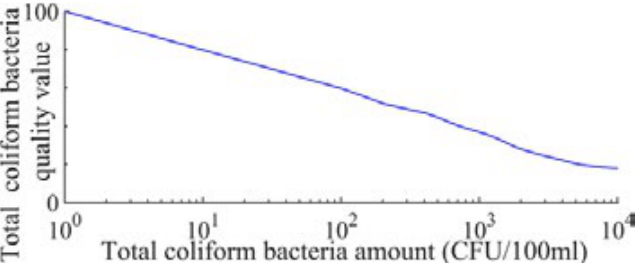
Fig. 3: The relationship between total coliform bacteria amount and its quality value Fig. 4: The relationship between total coliform bacteria amount and its quality